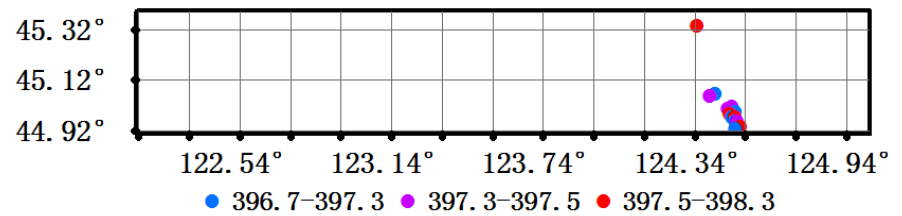
Figure 10. The XCO 2 estimates from OCO-2 in the flight test area.